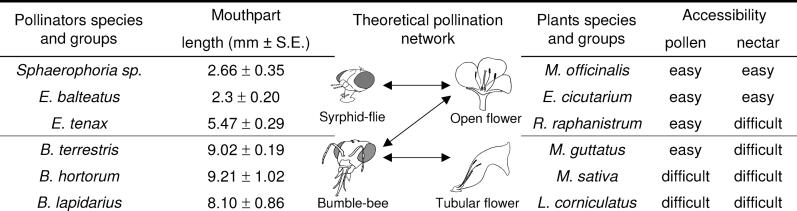
Experimental Pollination WebSummary of the characteristics upon which functional groups of pollinators (left) and plants (right) were based. In the middle, the arrows linking insect heads to flower types show the theoretical pollination network when all functional groups are present.